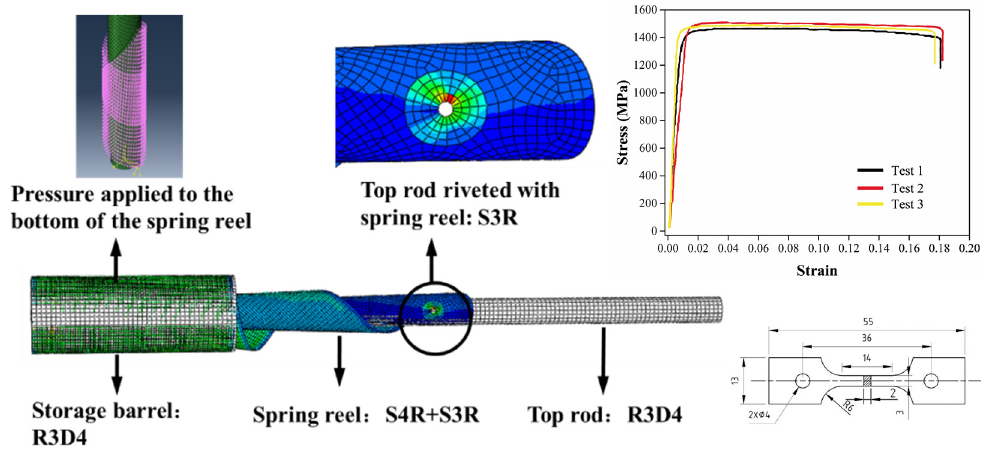
Figure 4. Finite element model of STACER with stress–strain curves and specimen geometry. Table 1. Specification of the STACER numerical model.